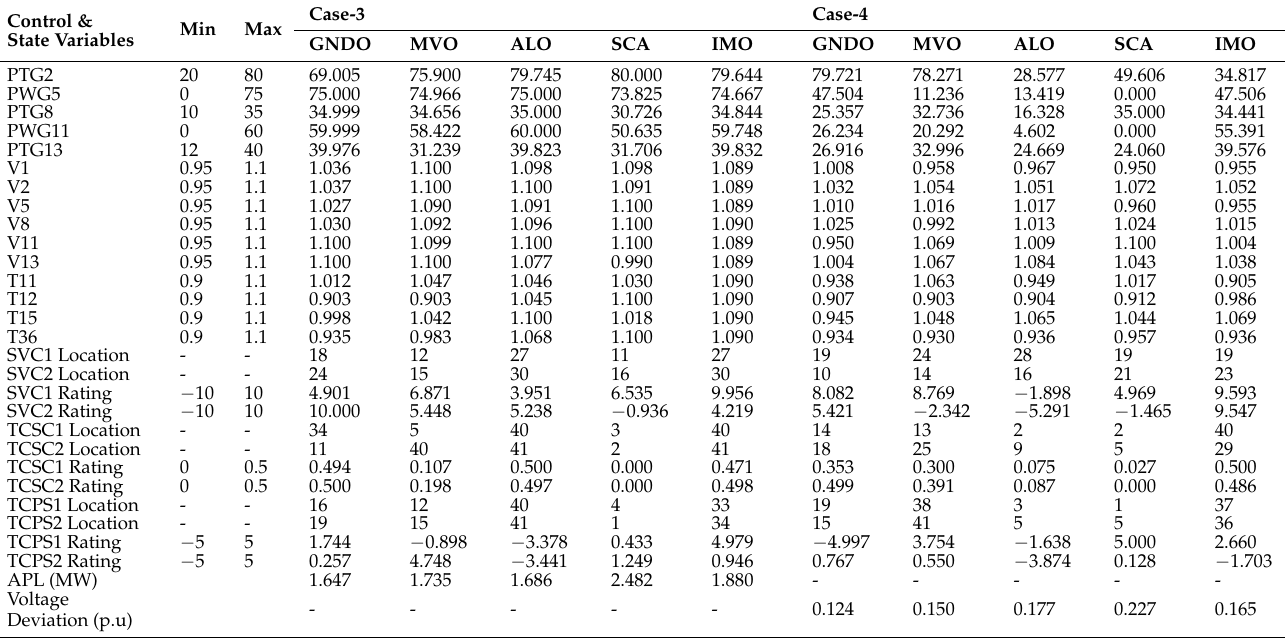
Table 10. Single objectives simulation results for case 3 and case 4.